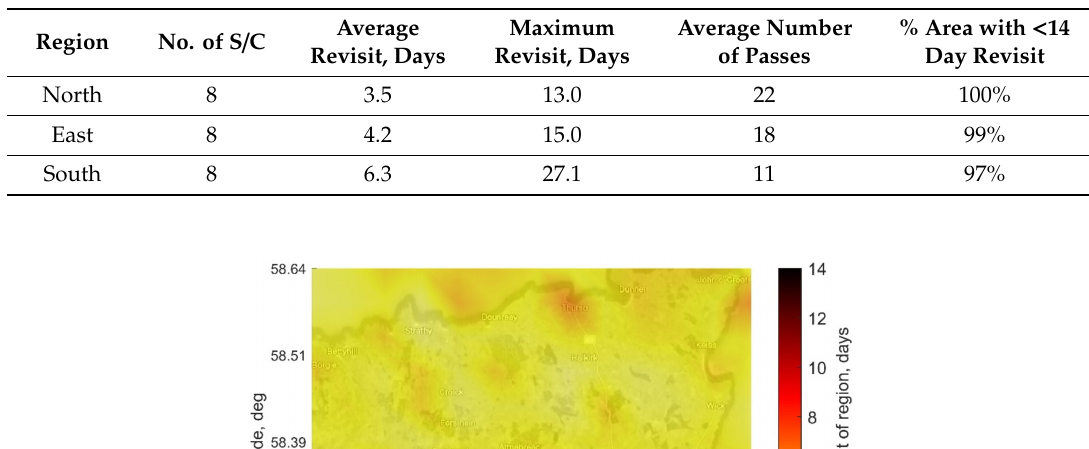
Table 7. Maximum and average coverage of selected regions of Scotland for a constellation of eight spacecraft in a 60 deg inclined RGT